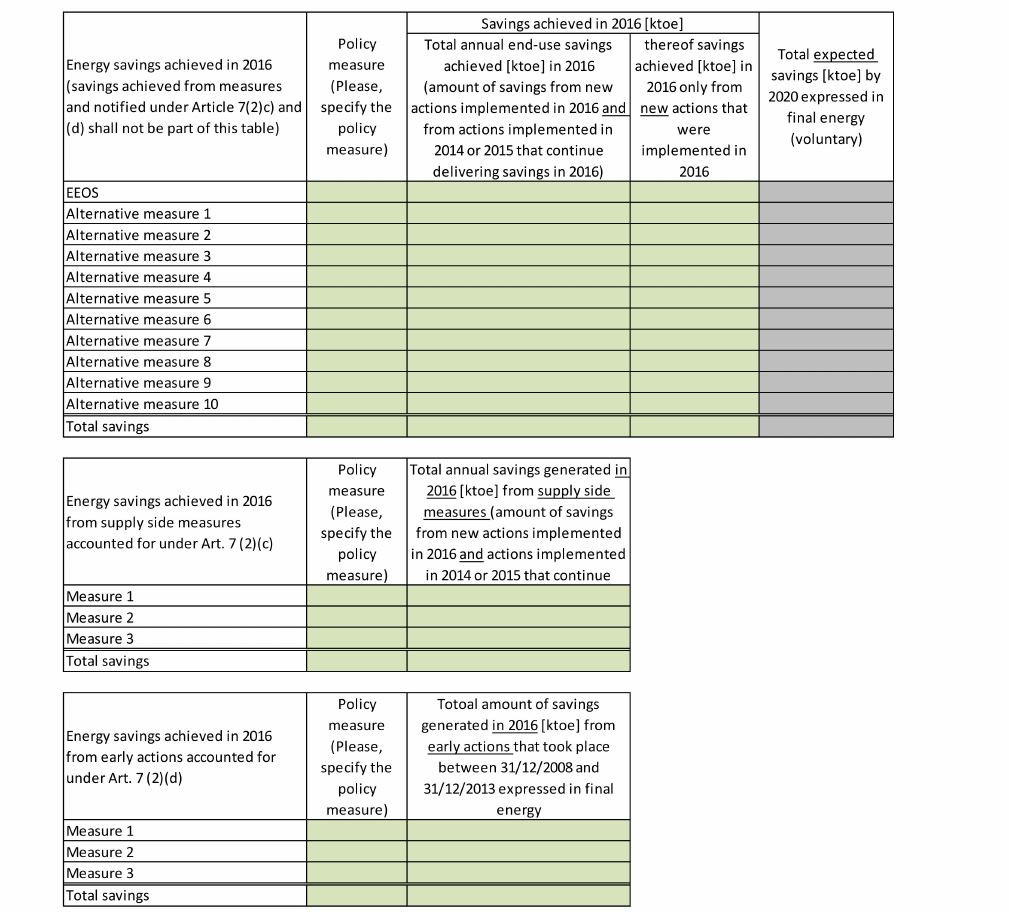
Figure A2. Common reporting template (part